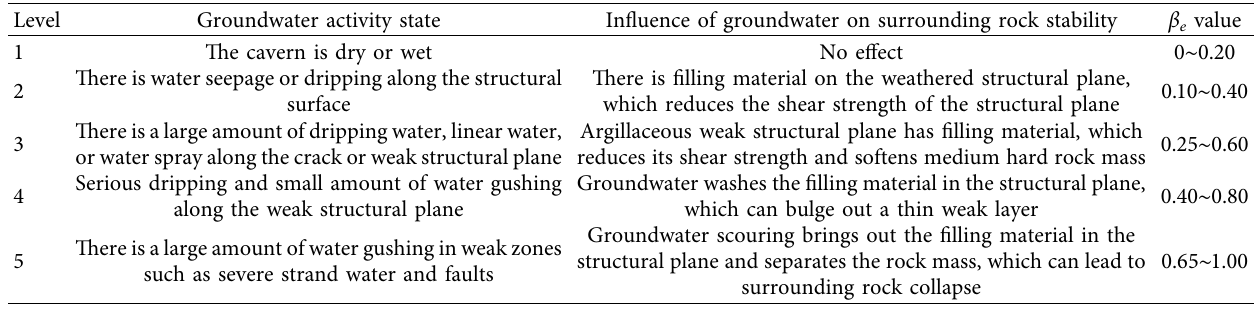
Figure 5: Failure mode diagram of each specimen (red curve represents macrocrack). Table 3: Reduction coefficient of external water pressure